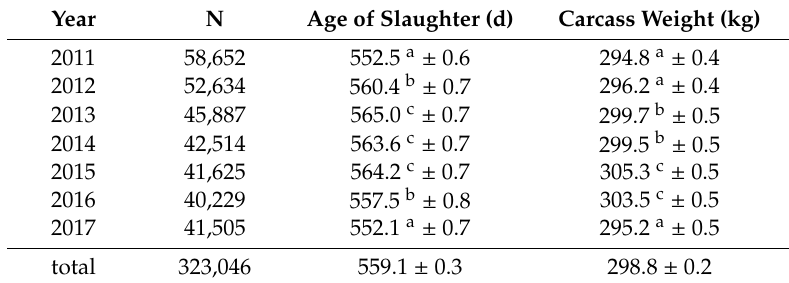
Table 2. Number of carcasses, means ± std. error for the age of slaughter (days, d) and carcass weight (kg) during 2011 to